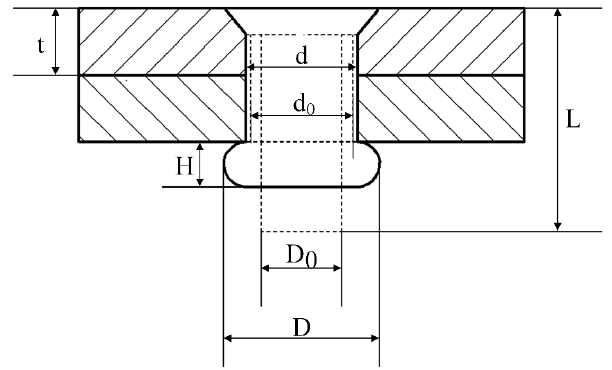
Figure 2. The geometric parameters of the riveted joint: t : plate thickness; L : rivet length; d 0 : riveted hole diameter before riveting; d : riveted hole diameter after riveting; D 0 : rivet diameter; D : driven head diameter; H : driven head height.